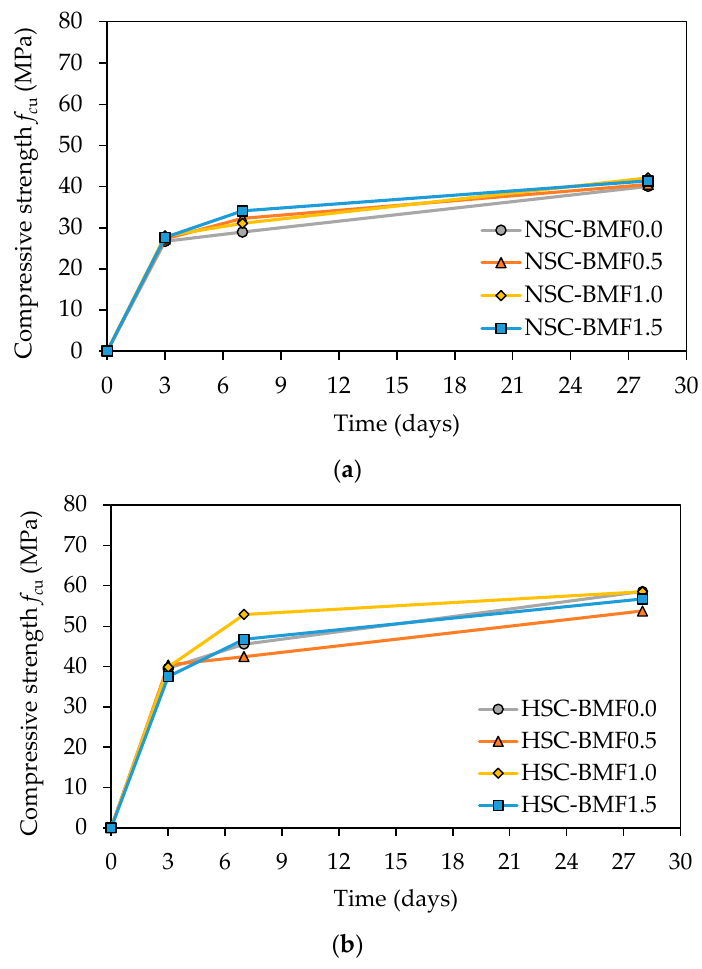
Figure 7. Development of cube compressive strength with time: ( a ) NSC; ( b ) HSC. The measured 28-day cube strengths ( f cu ) of benchmark NSC and HSC specimens were 40.0 and 58.6 MPa, respectively. The addition of BMF insignificantly improved f cu of the NSC by 1–5%. However, an insignificant reduction in the cube compressive strength of 4%, on average, was noticed for the HSC reinforced with BMF. Photographs of typical concrete cube specimens after failure are shown in Figure 8. The majority of the plain NSC cube specimens exhibited concrete spalling at failure (Figure 8a). The plain HSC cube specimens failed catastrophically, rendering a failure pattern shape of a shortened hourglass (Figure 8b). The NSC and HSC cube specimens with BMF exhibited fine cracks during testing, and remained coherent without disintegration at failure as shown in Figure 8c,d, respectively. The 28-day cylinder compressive strengths ( f’ c ) of the NSC and HSC are compared in Figure 9. The cylinder compressive strengths of the benchmark NSC and HSC specimens were 36.5 and 53.6 MPa, respectively. The addition of BMF insignificantly increased f’ c of the NSC by up to 4% but tended to decrease that of the HSC by 7 to 10%. Values of f’ c / f cu of different concrete mixtures are listed in Table 7. The ratio of f’ c / f cu for the NSC and HSC benchmark specimens was constant at a value of 0.91. For the NSC and HSC with BMF, the values were in the ranges of 0.90 to 0.93 and 0.85 to 0.90,